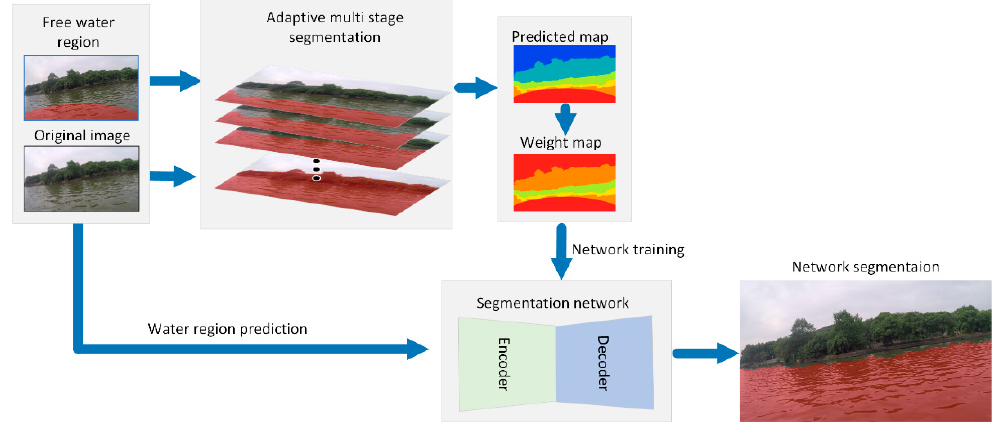
Figure 1. The diagram of the proposed method.